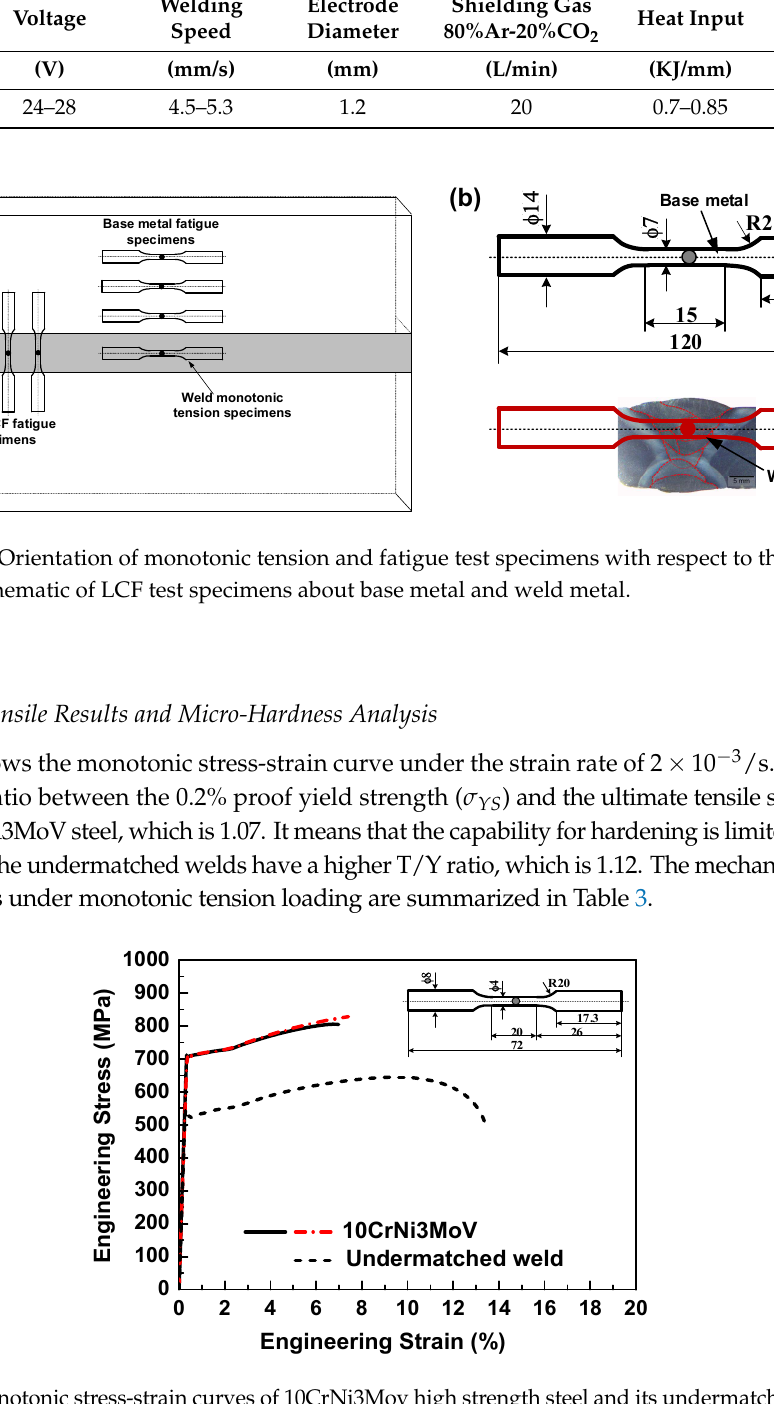
Table 2. Welding conditions of multi-pass plate for the fatigue specimens.